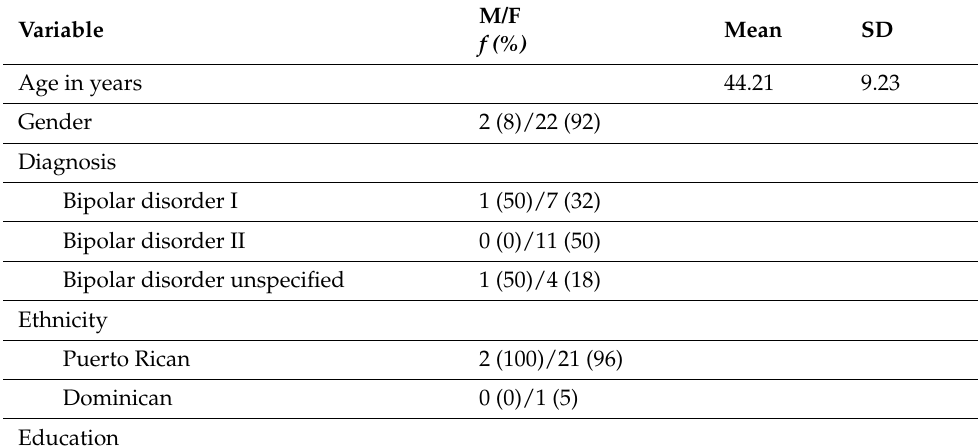
Table 2. 1 Sociodemographic data and psychiatric diagnoses of the 24